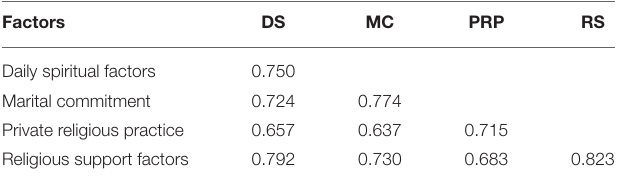
TABLE 11 | Effect size of the proposed study